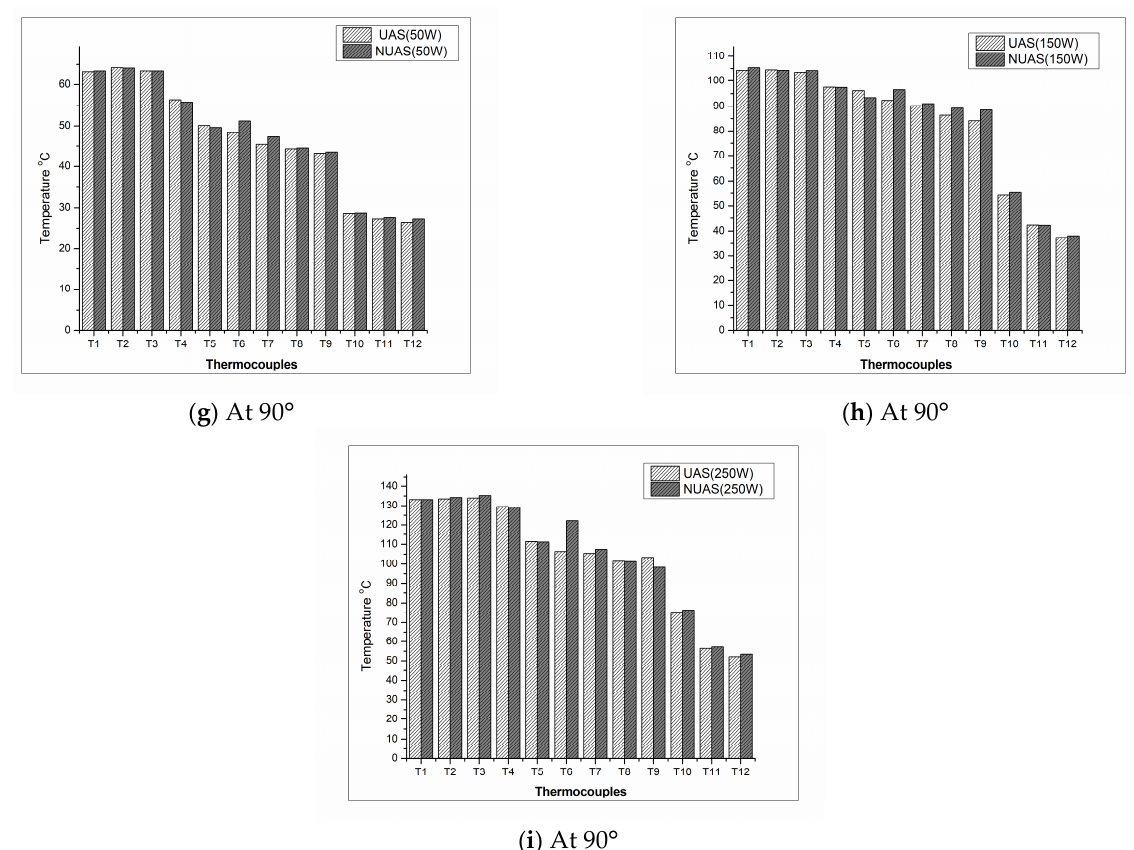
Figure 6. Temperature distributions at different orientations with various heat inputs ( a ) at the horizontal position and 50 W heat input ( b ) at horizontal position and 150 W heat input ( c ) at the horizontal position and 250 W heat input ( d ) at 45° and 50 W heat input ( e ) at 45° and 150 W heat input ( f ) at 45° and 250 W heat input ( g ) at 90° and 50 W heat input ( h ) at 90° and 150 W heat input ( i ) at 90° and 250 W heat input.